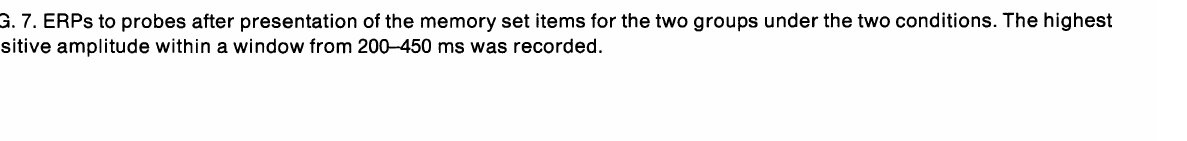
FIG. 7. ERPs to probes after presentation of the memory set items for the two groups under the two conditions. The highest positive amplitude within a window from 200--450 ms was